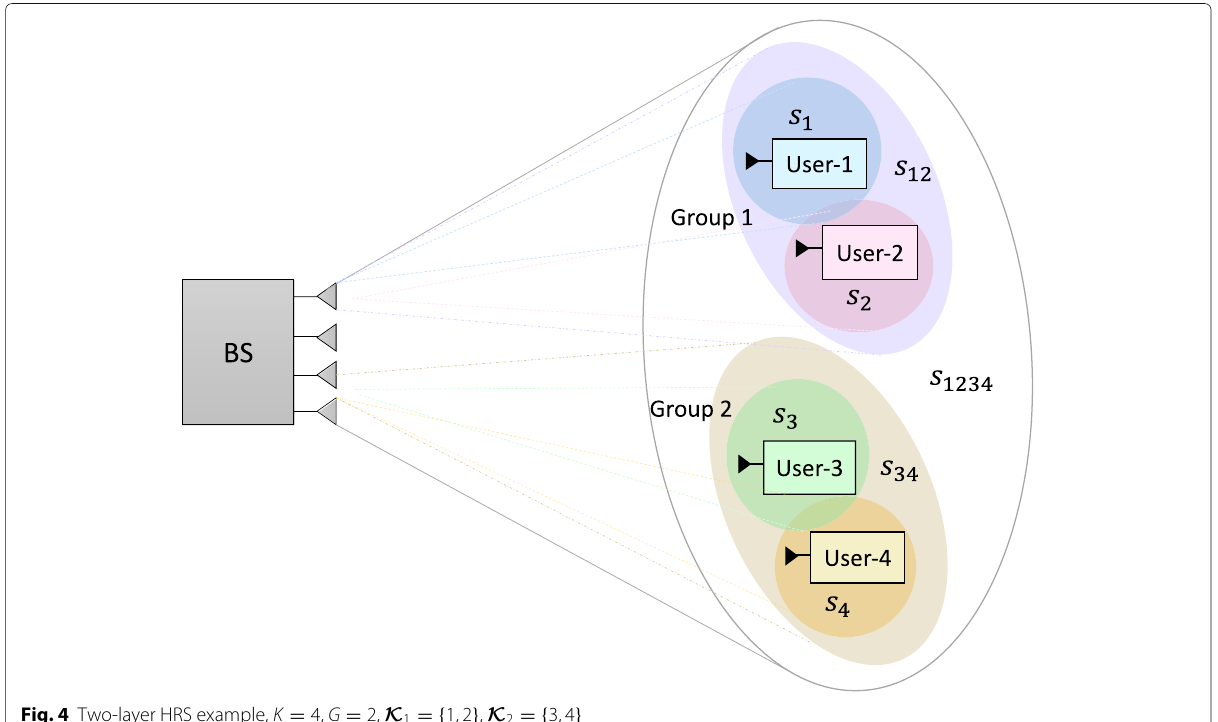
Fig. 4 Two-layer HRS example, K = 4, G = 2, K 1 = { 1,2 } , K 2 = { 3,4